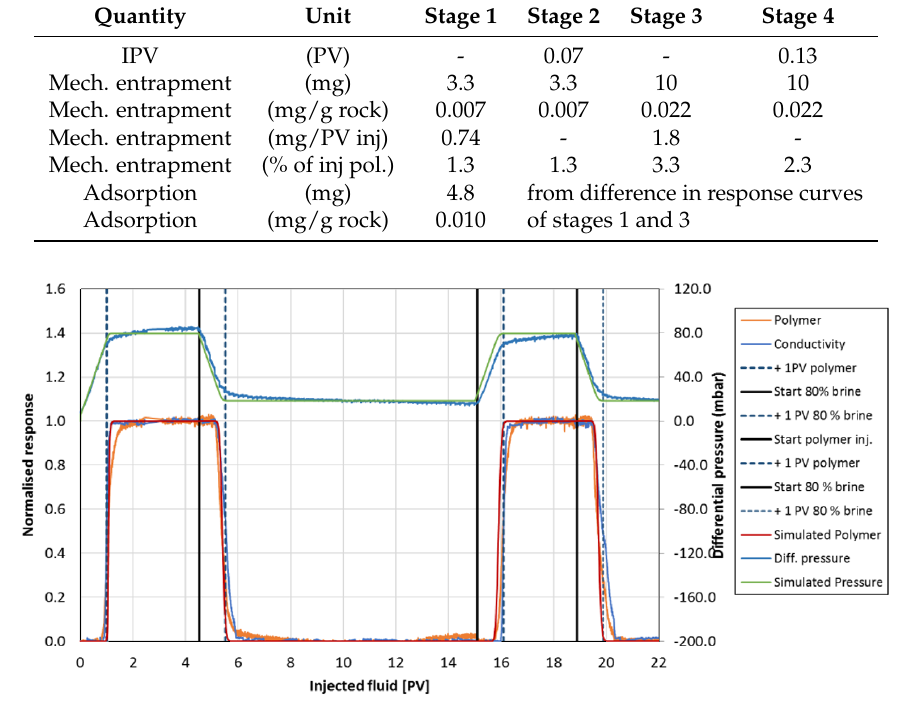
Figure 11. Comparison of normalized polymer concentration at the outlet of the core from the experiment and simulation of Experiment 2 (Bentheimer): Conductivity measurements from the experiment and differential pressure over the core are also plotted.